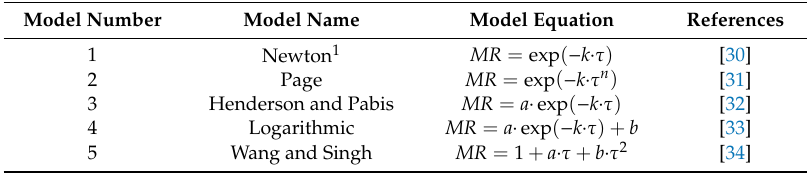
Table 1. Equations applied to the drying